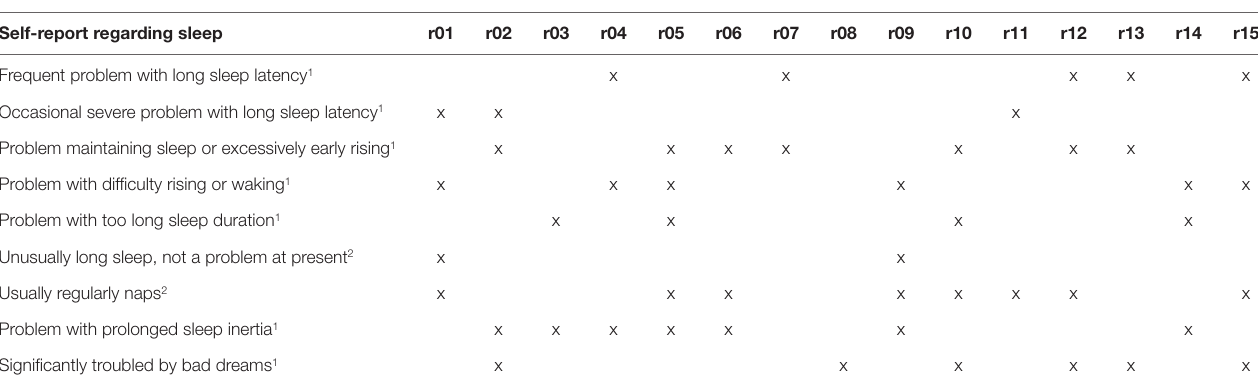
TABLE 2 | Qualitative summaries of participant’s description of their sleep problems. Self-report regarding sleep